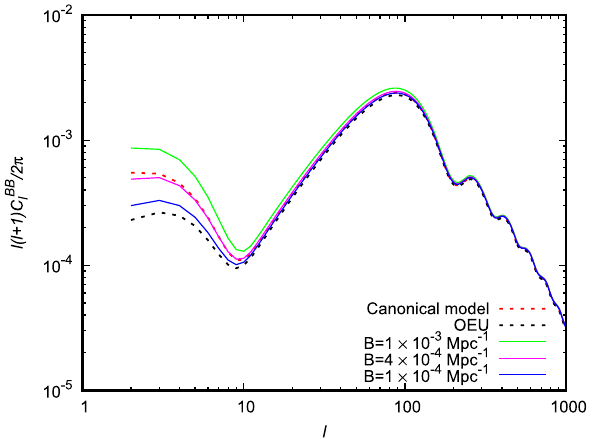
Fig. 2 Predicted B -mode spectra, when the CSL effect is (practically) turned off (i. e. B = 0) for different values of the emergent model parameter a 0 H 0 . The canonical (cid:2) CDM model is also displayed In Fig. 2, we see that the value a 0 H 0 = 2 × 10 − 4 Mpc −